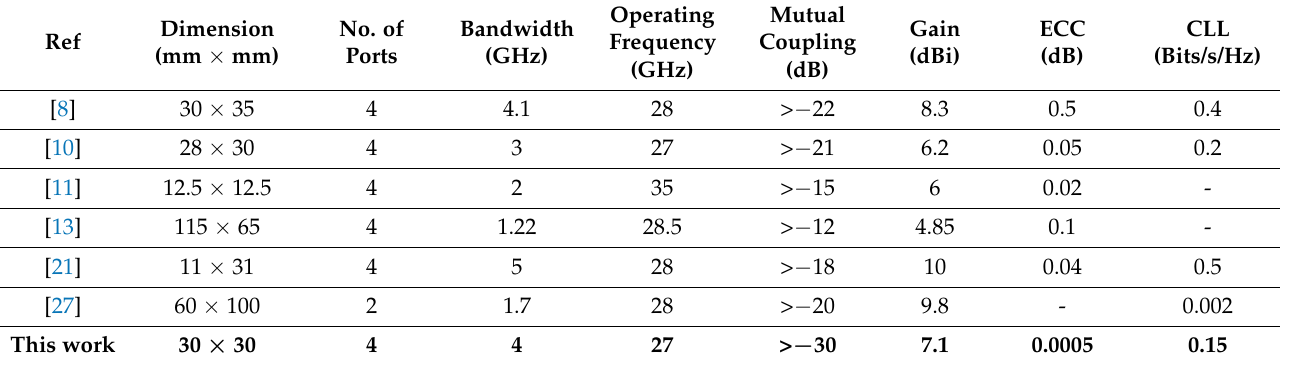
Table 2. Comparison of proposed work with state-of-the-art